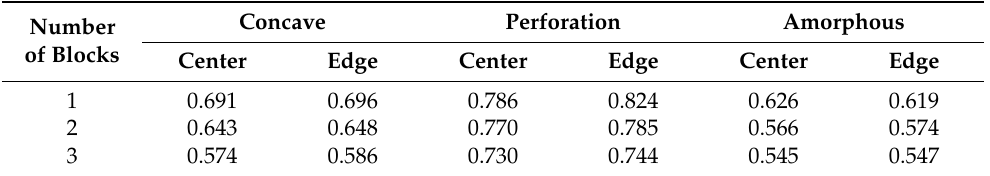
Table 3. DPL at the center and edge when the selected number of blocks by different methods is